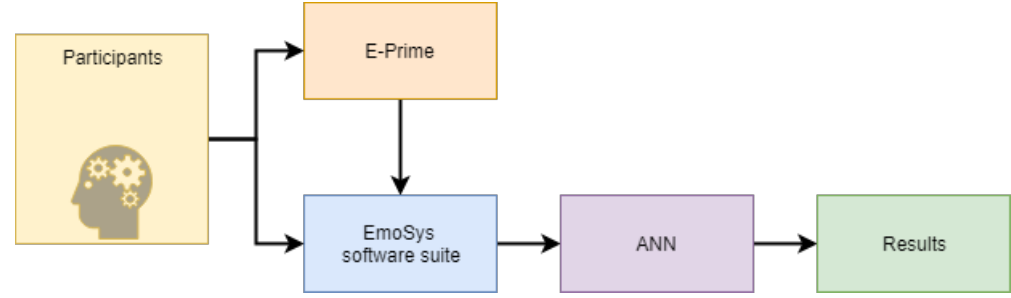
Figure 6. Flowchart of the experimental design. Artificial neural network (ANN).